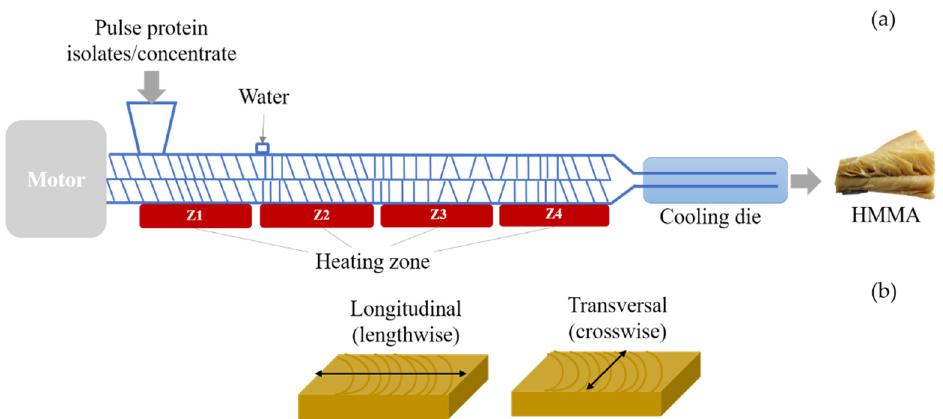
Figure 1. ( a ) Schematic diagram of a twin-screw extruder and cooling die, modified illustration adopted from Maung & Ryu [7] and ( b ) cutting directions on high-moisture meat analogue (HMMA) in cutting strength measurements.